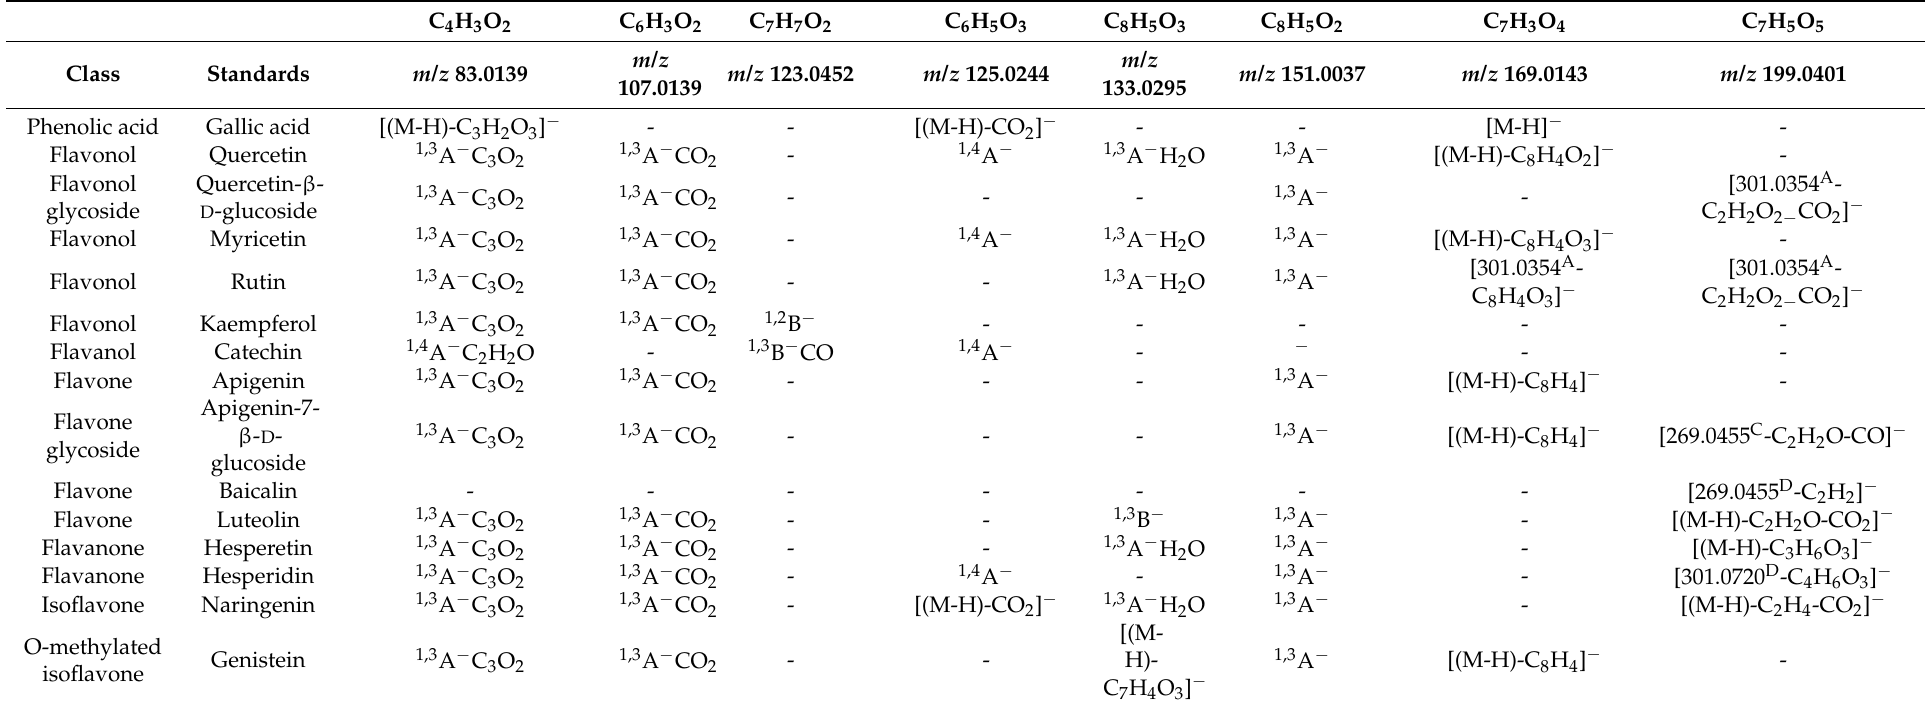
Table 1. Flavonoid-specific fragment ions identified by the infusion of gallic acid and 14 flavonoid standards and their targeted MS 2 fragmentation in conditions. (A) 301.0354: quercetin; (B) 269.0455: apigenin; (C) baicalein; (D) hesperidin. Fragmentation nomenclature was given based on Gates and Lopez (2012) [37], Barnaba et